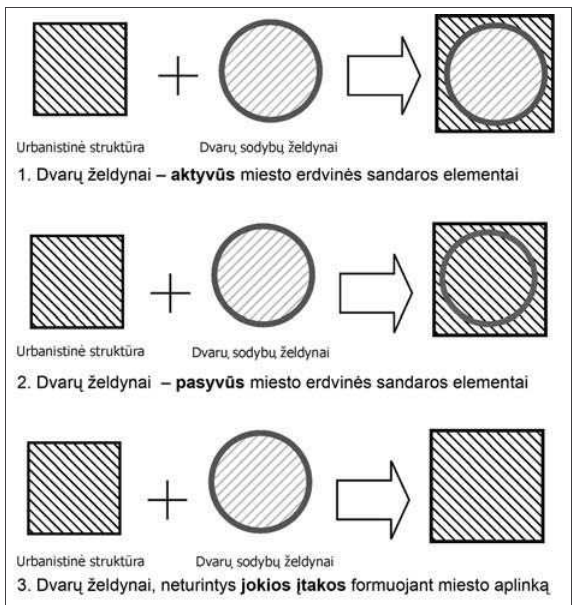
Fig 1. Role of manor greenery in the context of urban